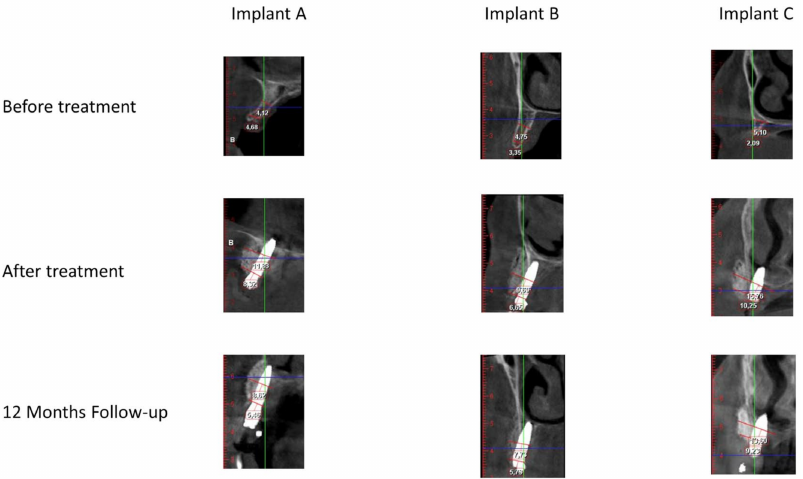
Figure 1. Example of measurements in three implant sites from different patients ( A – C ) evaluated through CBCT scans using the Planmeca Romexis ® Version 2.5.1.R. Images correspond to